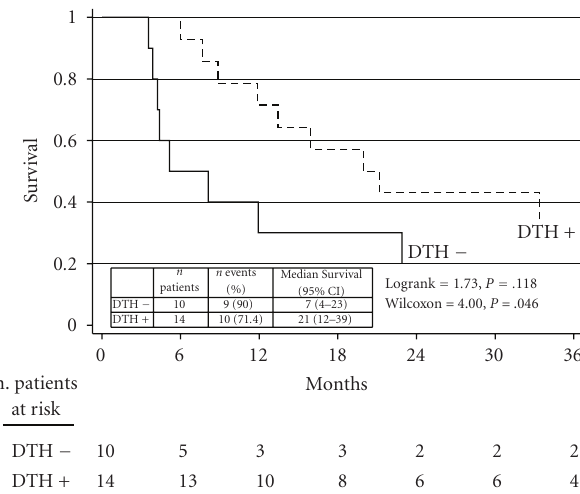
Figure 2: Update of OS curves in 24 vaccinated patients according to DTH ( P = . 046).